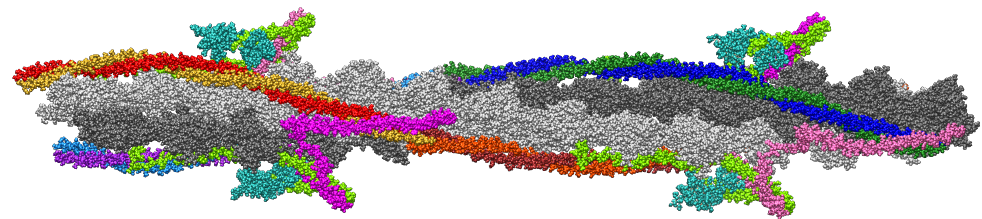
Figure 1. A refined atomic model (Model 1) of a segment of a thin filament of cardiac muscle. The pointed end of F-actin is on the left. The z -axis in the model coincides with F-actin axis and it is directed from left to right. Actin is shown in light gray and dark gray (long helices 1 and 2, respectively), strand 1 of Tpm is red and light brown or dark brown and orange; strand 2 is light blue and purple or blue and dark green; Tn-C is sea green, Tn-I is light green; two structurally different Tn-T are hot pink (Tn-T1) and magenta